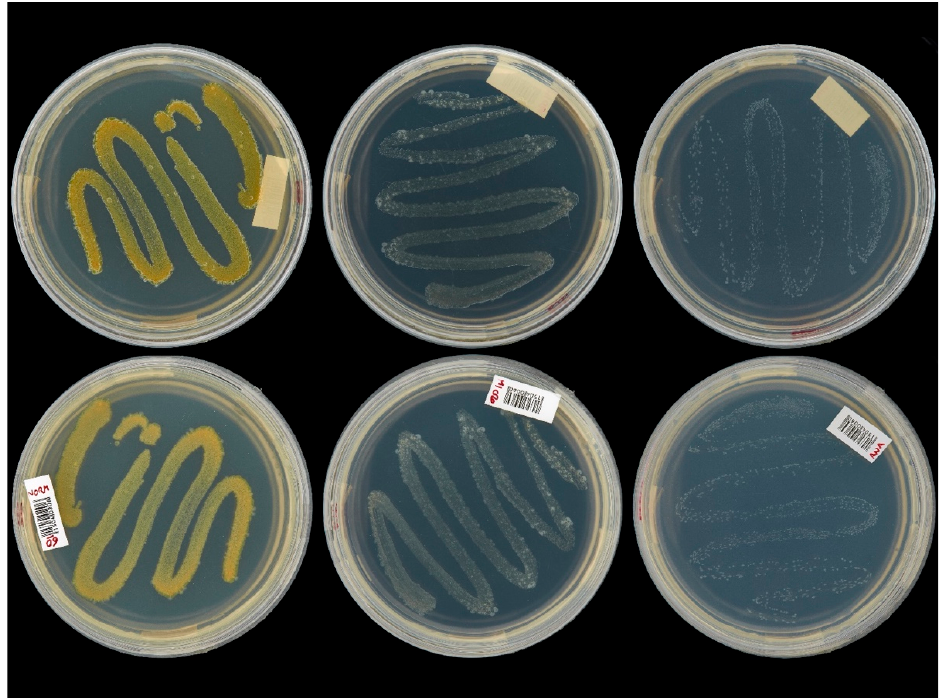
Figure 4. Bacterial isolates obtained by inoculation of unique JAF on nutrient agar incubated under uncontrolled oxygen ( left ), microaerophilic ( middle ), and anaerobic ( right ) conditions, respectively, using Oxoid™ AnaeroJar™; upper and lower face.